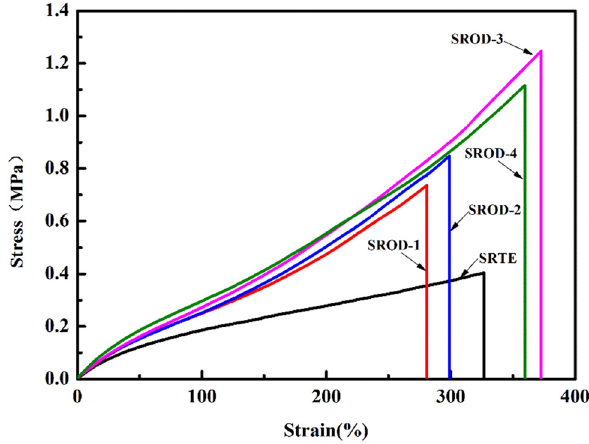
Figure 6: Stress – strain curves of RTV silicone